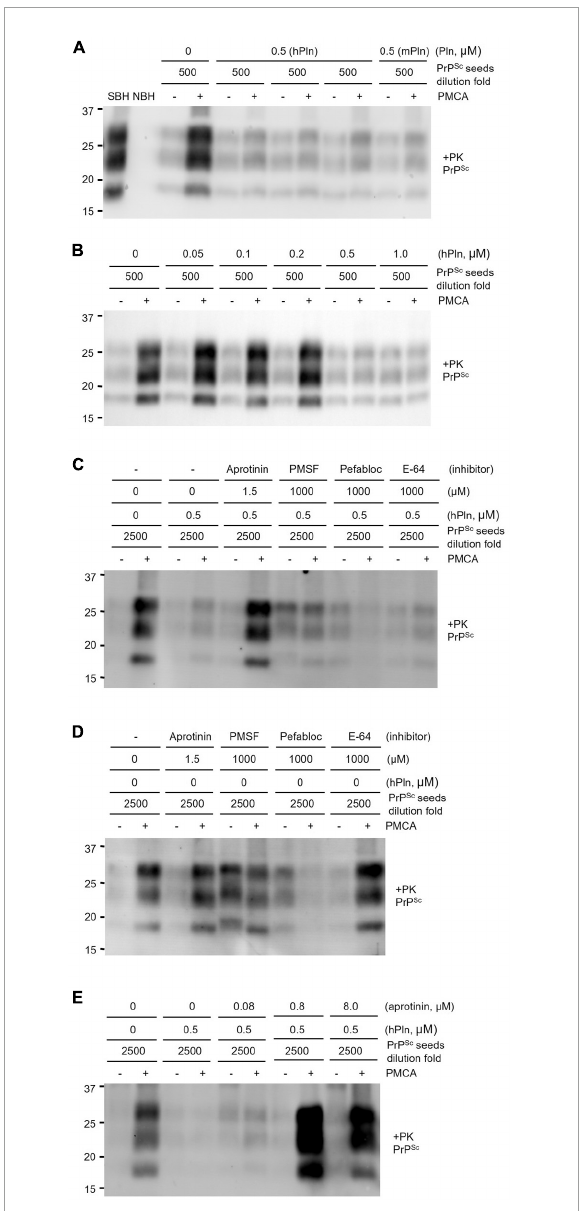
FIGURE4 PMCA inhibited by supplementation with plasmin. Sick